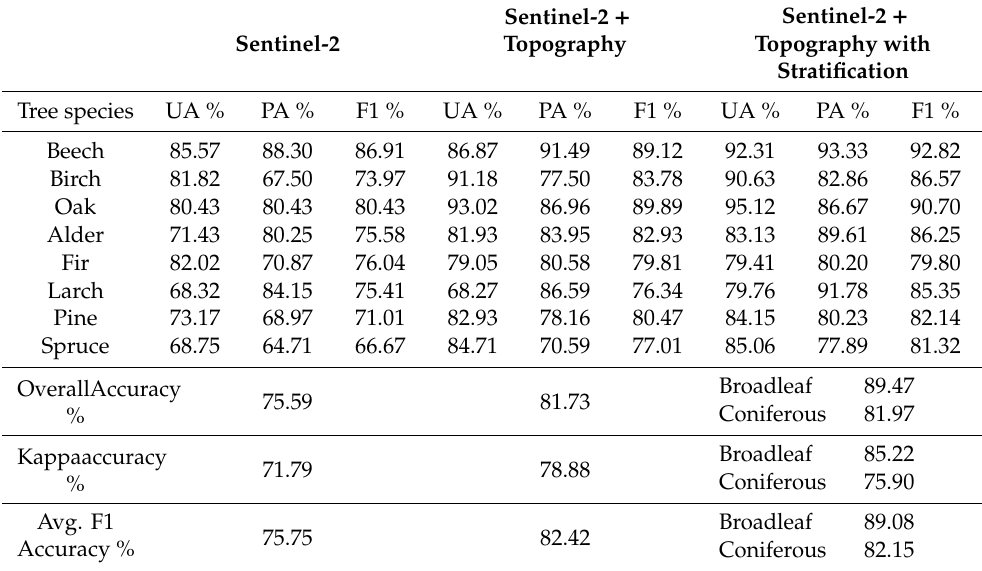
Table 4. Accuracy assessment for di ff erent tree species classification scenarios.